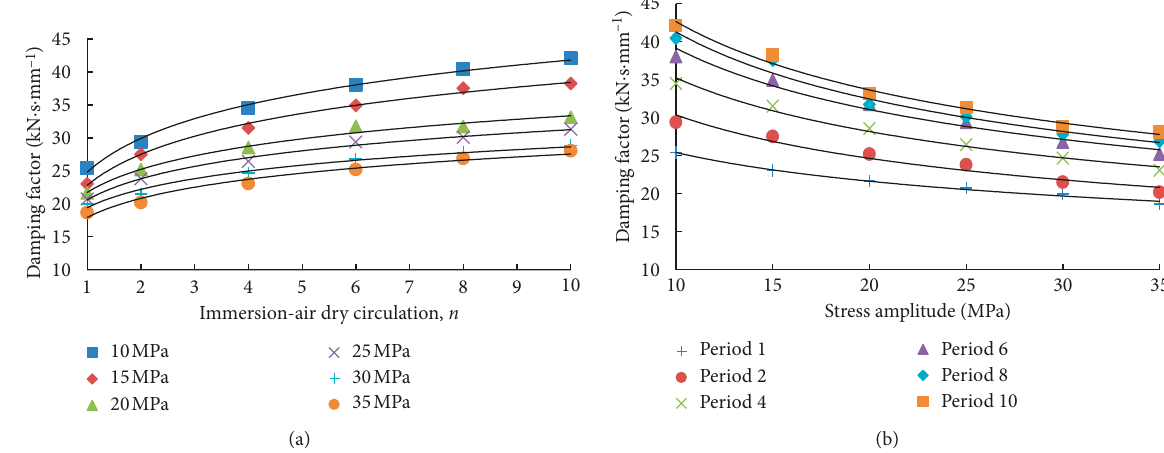
Figure 10: Damping factor variation curves of the rock sample under water-rock interaction. (a) The relation curve of damping factor with water-rock cycle. (b) The relation curve of damping factor with cyclic load stress amplitude.